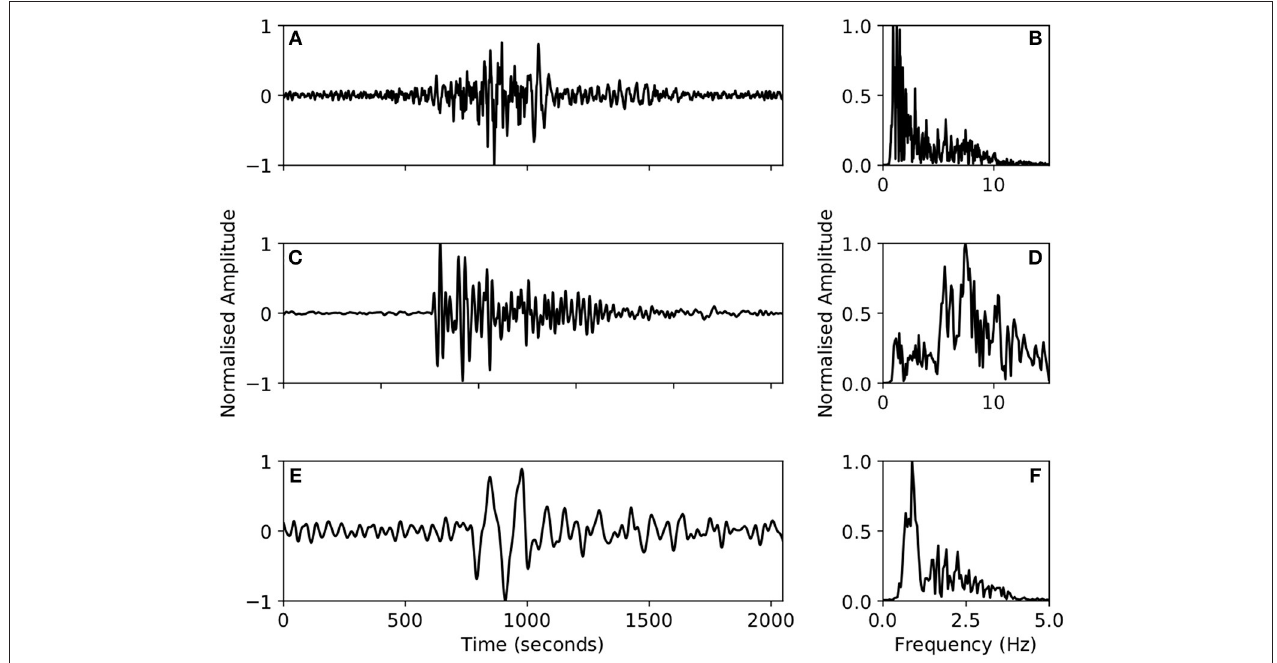
FIGURE 2 | Time series and frequency spectrum (normalized) of representative waveforms identified at Poás in March 2017. (A,B) Low frequency event, 29 March 2017 00:35:45, band-pass filtered between 1 and 15 Hz. (C,D) High frequency event, 26 March 2017 09:23:10, band-pass filtered between 1 and 15 Hz. (E,F) Very low frequency event, 27 March 2017 13:47:30, band-pass filtered between 0.5 and 3